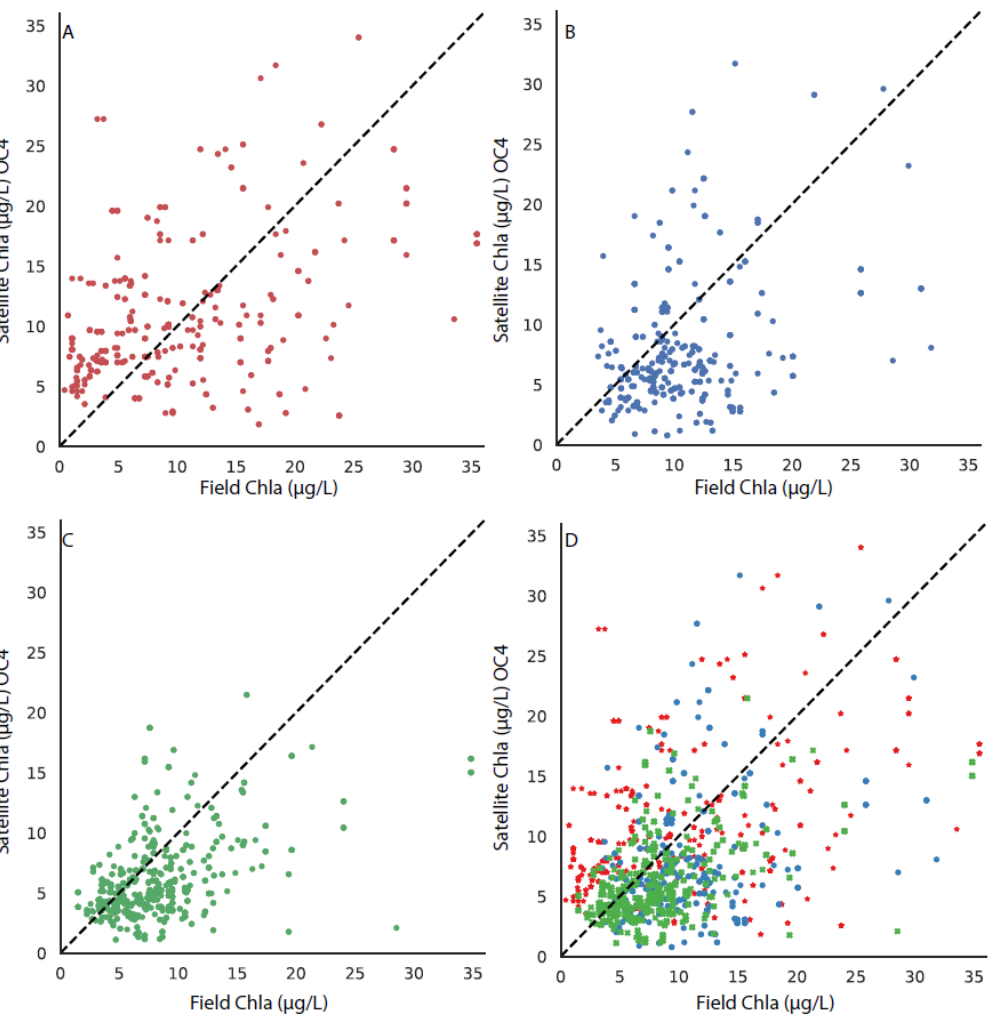
Figure 3. The matchup between the field chla and the OLCI-OC4 algorithm, with the 1:1 line shown in each subplot for stations in ( A ) the upper bay, ( B ) the middle bay, ( C ) the lower bay, and ( D ) all stations, with the upper, middle, and lower bays differentiated by symbol color and style.